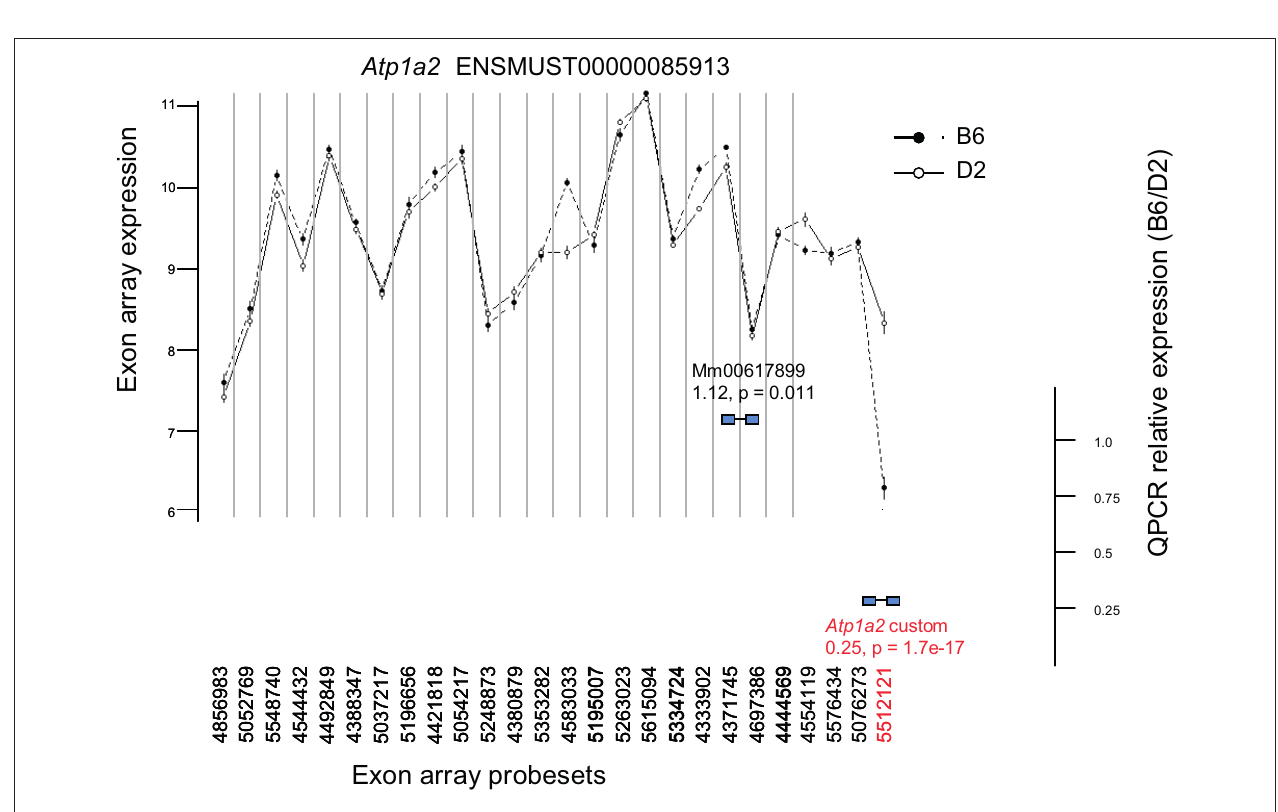
FiguRe A2 | Atp1a2 , an additional qPCR confirm. Legend is identical as for Figure 6